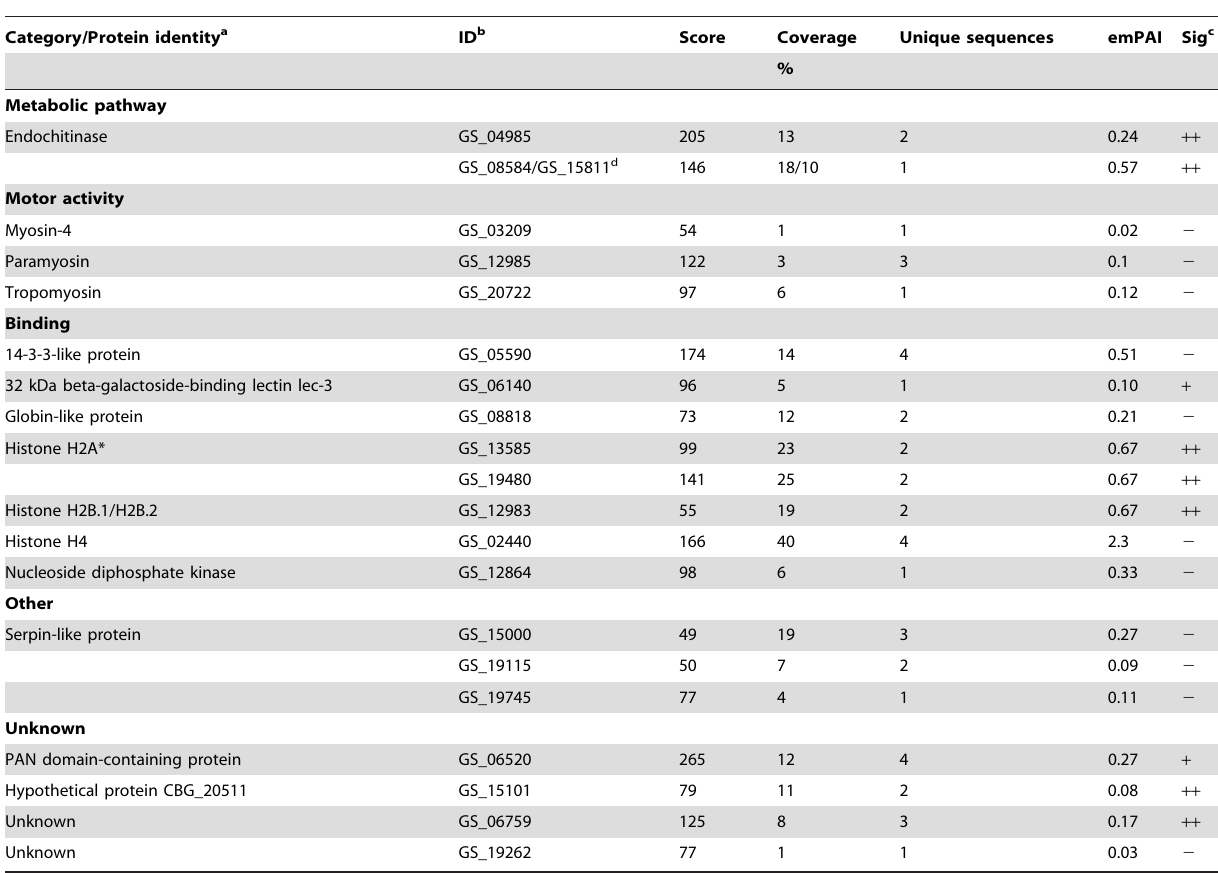
Table 1. Protein identifications in A. suum L3-egg ES products.